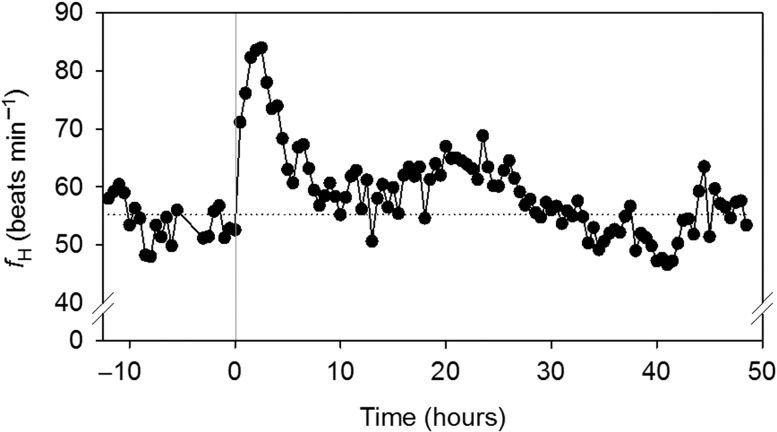
Heart rate (fH) trace of an individual sockeye salmon before, during, and after fisheries pressure simulation. Sockeye salmon was exposed to the 16°C temperature treatment. Dashed line represents the routine fH. The gray line represents the fisheries capture simulation start at Time 0.